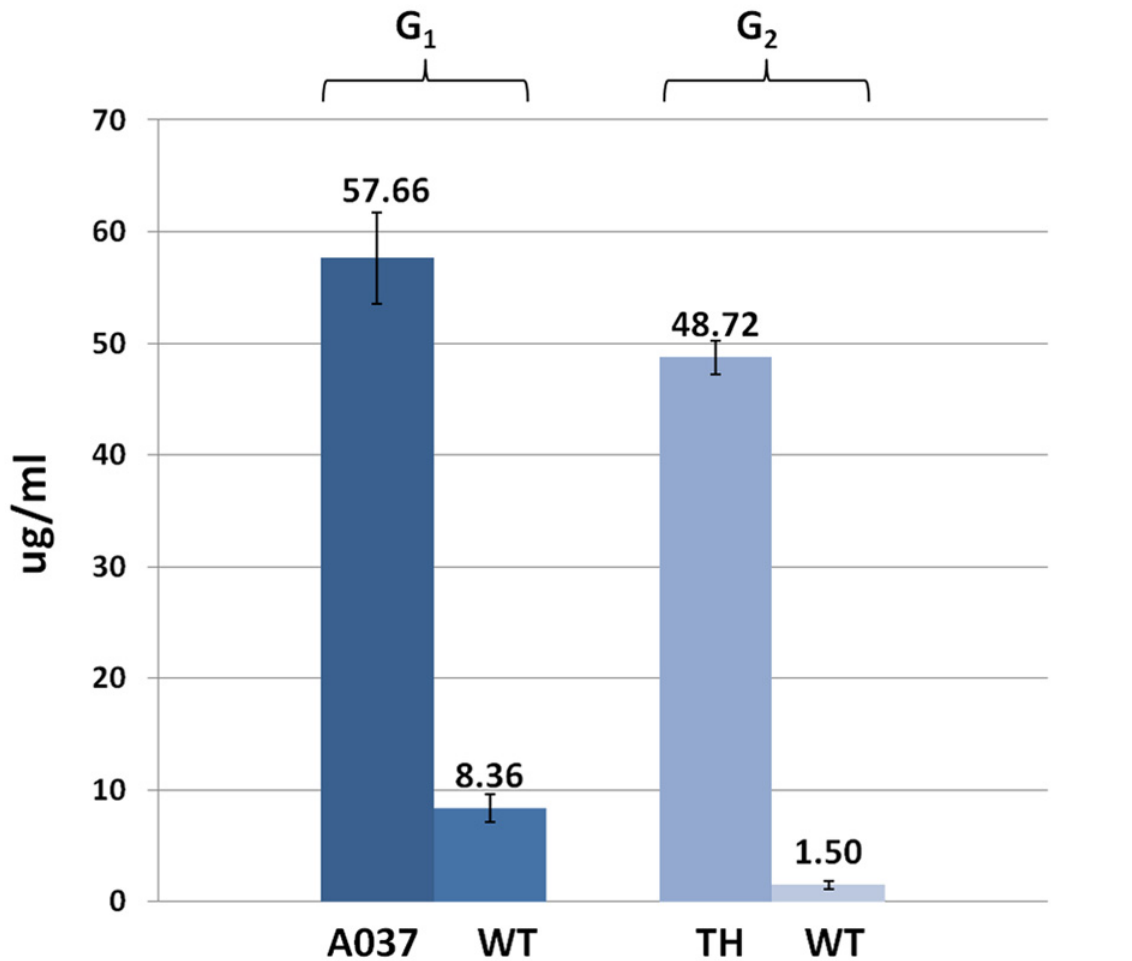
Fig 8. The concentration of recombinant human lysozyme in the egg whites from transgenic